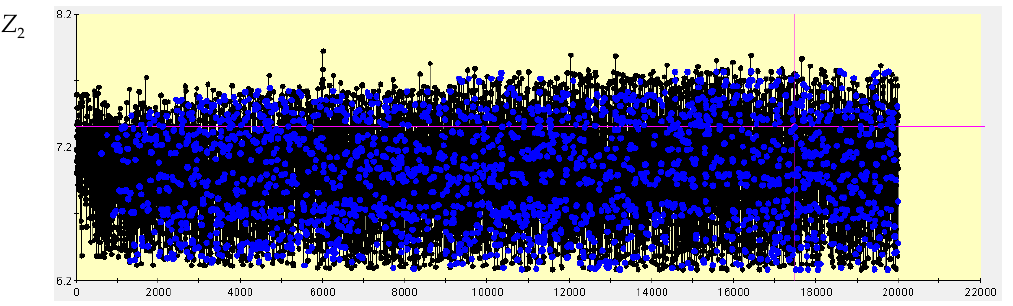
Figure 10. NSGA-II optimization process for all objectives.